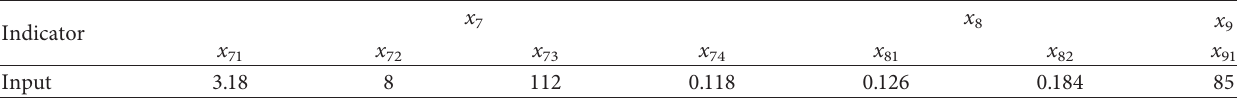
Figure 9: Cloud figures for environmental vulnerability (Blue for Level (I), Green for Level II, Yellow for Level III, Brown for Level IV, Red for Level (V), and Black for assessment value). (a) x 41 . (b) x 42 . (c) x 43 . (d) x 44 . (e) x 45 . (f) x 46 . (g) x 47 . (h) x 51 . (i) x 52 . (j) x 52 . (k) x 61 . (l) x 62 . Table 8: Assessment inputs of social vulnerability